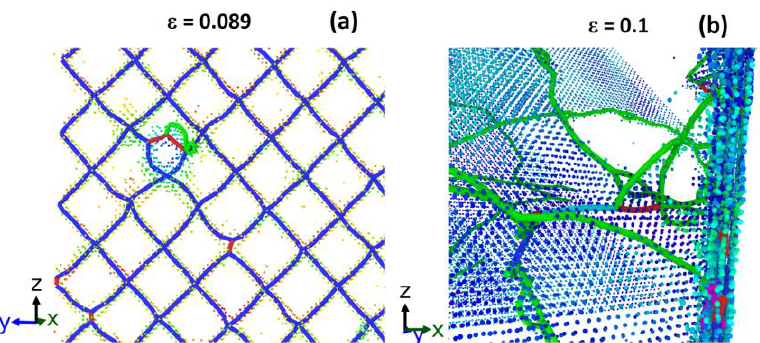
Figure 6. The interface between materials in the bisystem: ( a ) the network of perfect dislocations (blue lines) is visible, which arises due to the difference in the lattice constants of aluminum and copper in the initial state, and the nucleation of a dislocation half-loop propagating into aluminum (green lines correspond to partial Shockley dislocations, red lines correspond to stair rod dislocations); ( b ) Partial Shockley dislocations and stacking fault planes bounded by them in aluminum on the left side of the panel, the interface between aluminum and copper on the right side of the panel. Only atoms with high values of the centrosymmetry parameter are